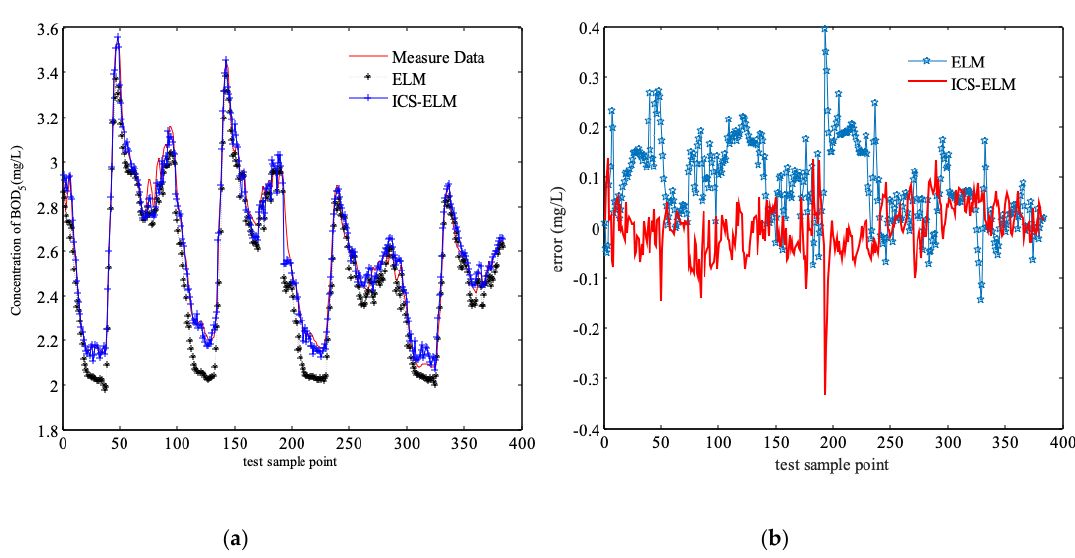
Figure 5. Compared prediction results of improved cuckoo search algorithm-based extreme learning machine (ICS-ELM) and basic ELM under dry weather condition, ( a ) effluent BOD concentration, ( b ) error in predicting the measured effluent BOD.